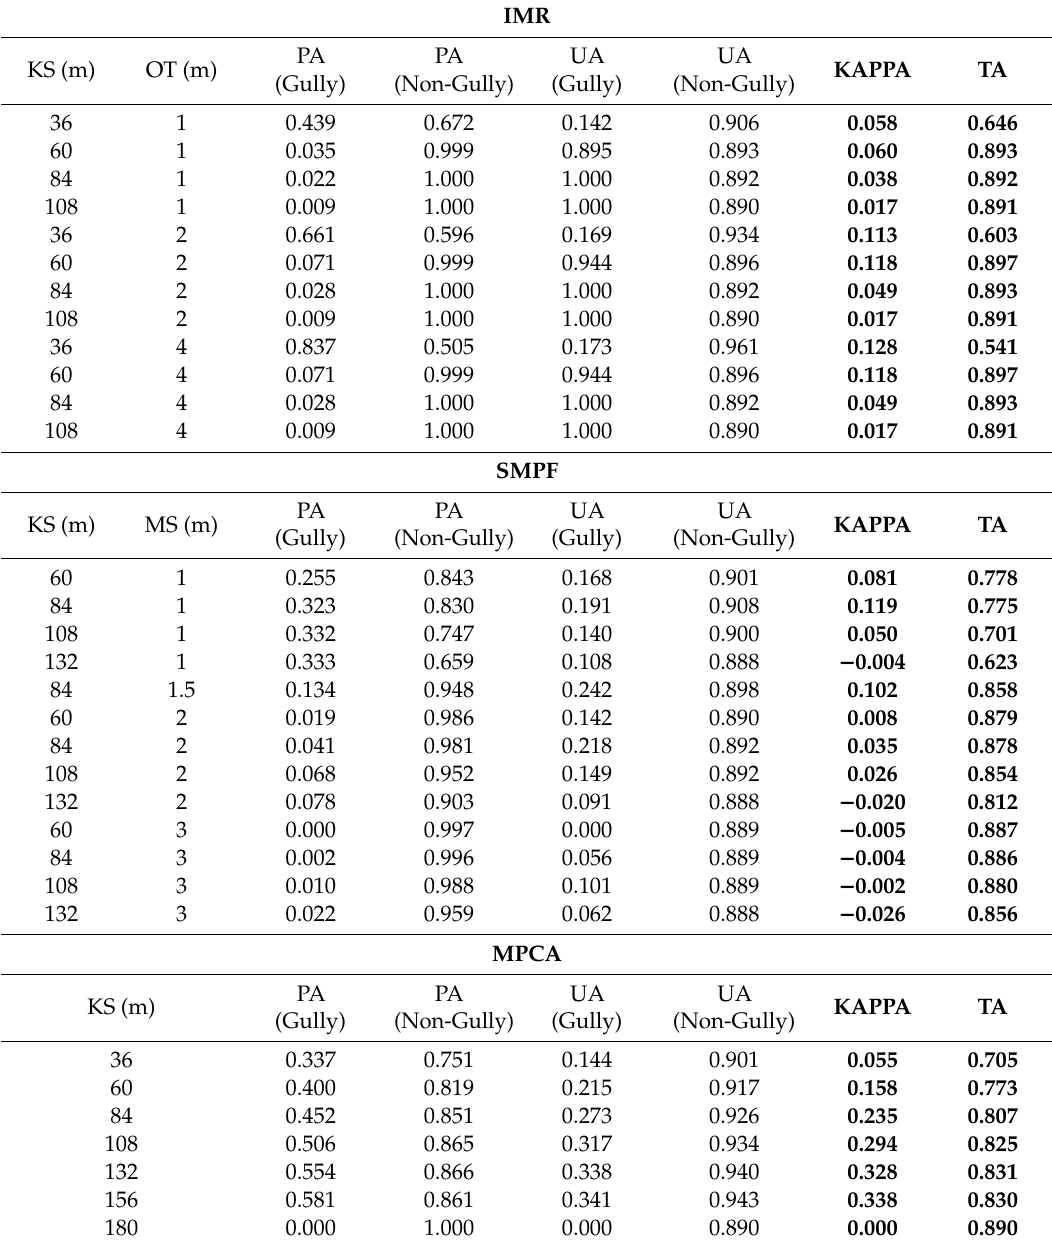
Table 3. Results of the three algorithms tested with di ff erent configuration settings. The following parameters are evaluated and compared: Kernel Size (KS), Mask Shift (MS), O ff -Terrain Threshold